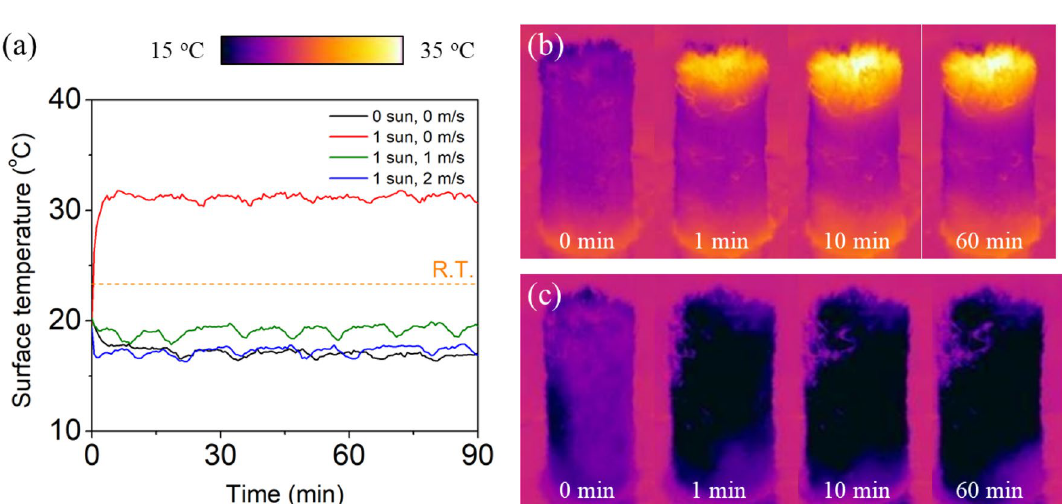
Figure 6. ( a ) Time-dependent changes in the average temperature at the top surface of CLS under various conditions. Time-lapse IR images of the CLS ( b ) under 1-sun illumination and no wind, ( c ) under 1-sun illumination and 2 m/s